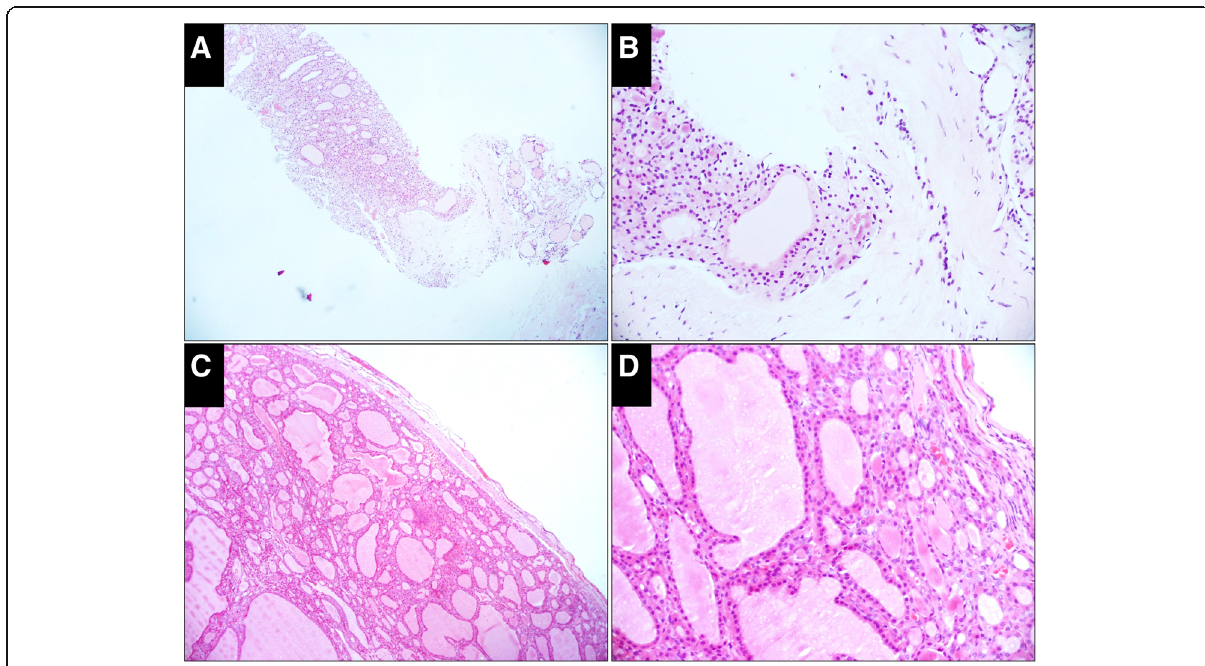
Fig. 4 Case classified as follicular neoplasm in both the CNB and resected specimens (H&E). a , The CNB specimen shows a microfollicular proliferative lesion with a fibrous capsule separating it from the normal follicles (× 50). b , High-power view shows proliferative follicles on the left of the capsule and the normal follicles on the right (× 200). c , An encapsulated follicular nodule with a complete thin capsule is prominent in the resected specimen. No capsular and vascular infiltration is detected (× 50). d, High-power view of the cells shows nuclei without features of papillary thyroid carcinoma (×